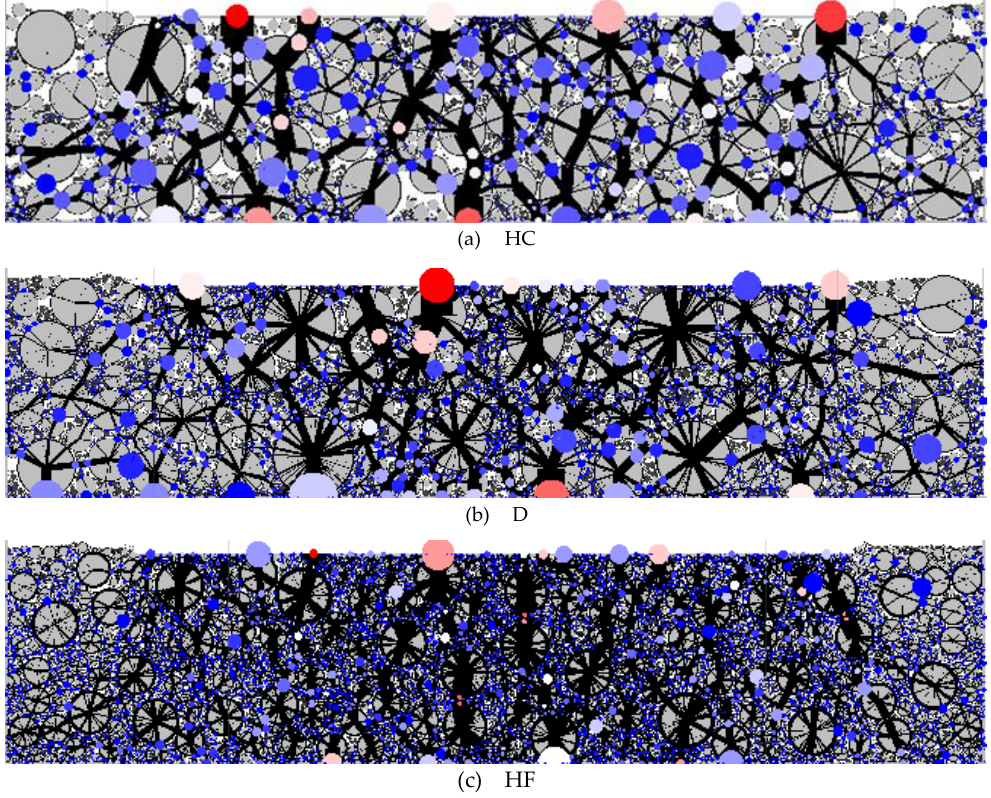
Figure 11. Distribution of contact force and contact points in mixture skeletons.